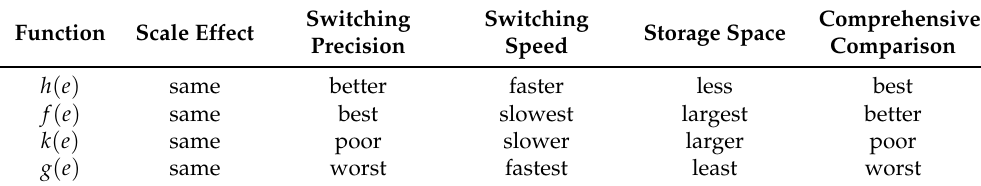
Figure 3. Mathematical curves of four cooperative control coefficients under different scale parame- ters. ( a ) The curves of four kinds of cooperative control coefficient with σ = 0.01. ( b ) The curves of four kinds of cooperative control coefficient with σ = 0.05. ( c ) The curves of four kinds of cooperative control coefficient with σ = 0.1. ( d ) The curves of four kinds of cooperative control coefficient with σ = 0.5. Table 2. The form of cooperative control